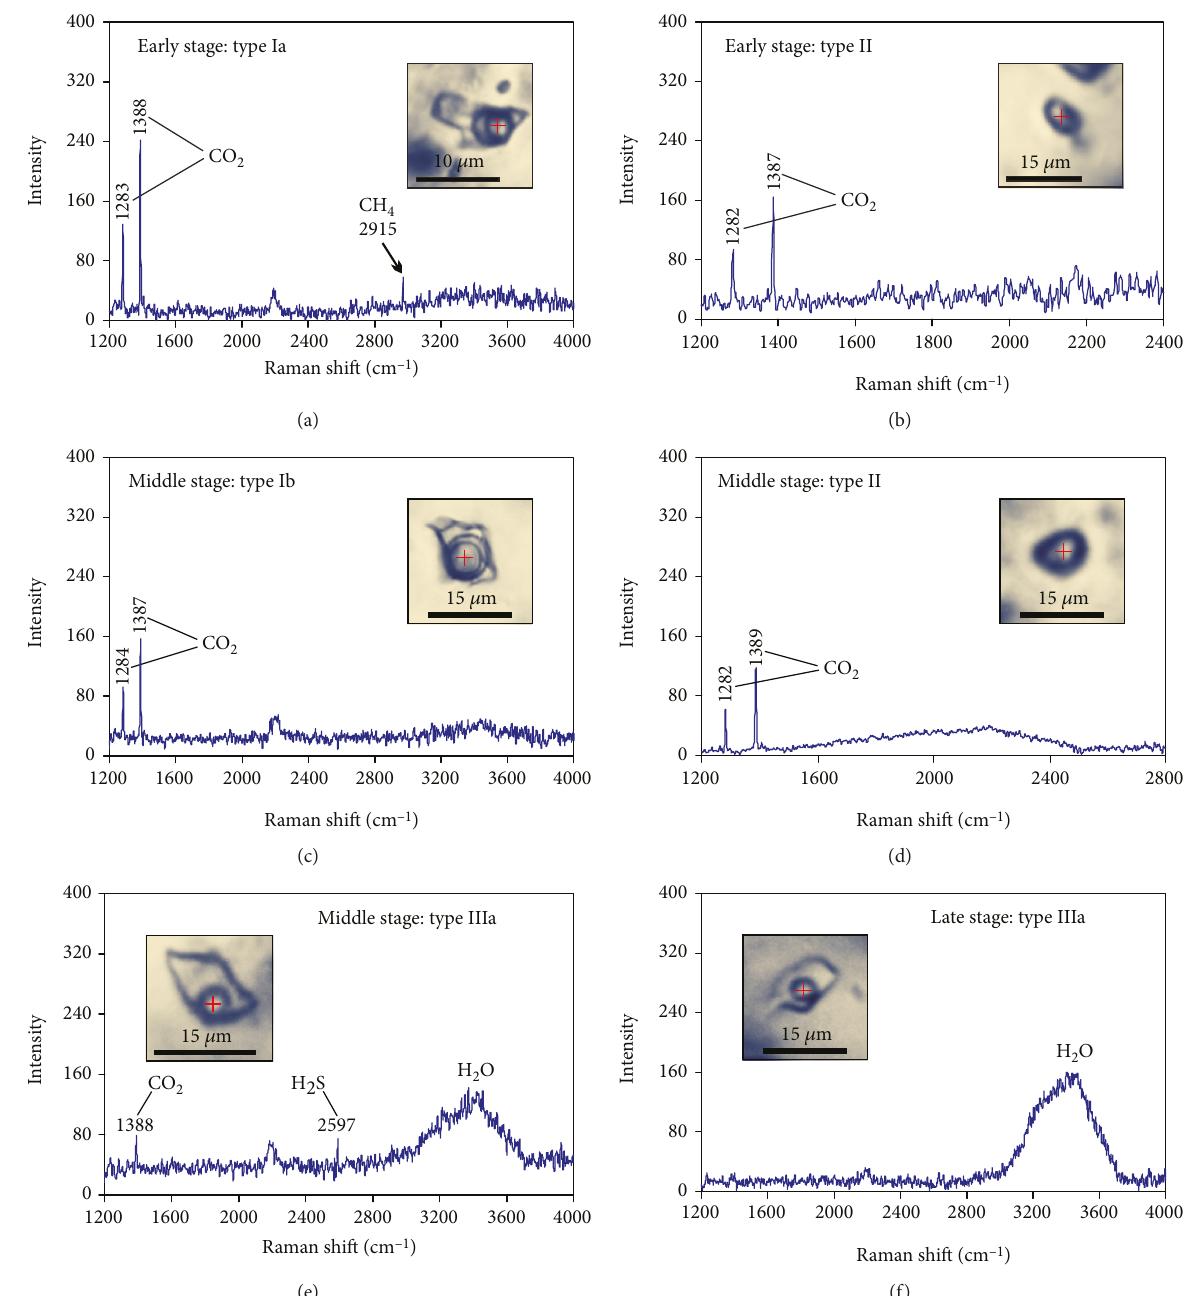
Figure 10: Representative laser Raman spectra of fl uid inclusions. (a) Spectrum for the gas phase of type Ia inclusion in the early stage with ; (b) spectrum for the gas phase of type II inclusion in the early stage; (c) spectrum for the gas phase of type Ib inclusion in few contents of CH 4 the middle stage; (d) spectrum for the gas phase of type II inclusion in the middle stage; (e) spectrum for the gas phase of type IIIa inclusion in the middle stage with few contents of H S and CO ; (f) spectrum for the gas phase of type IIIa inclusion in the late 2 2